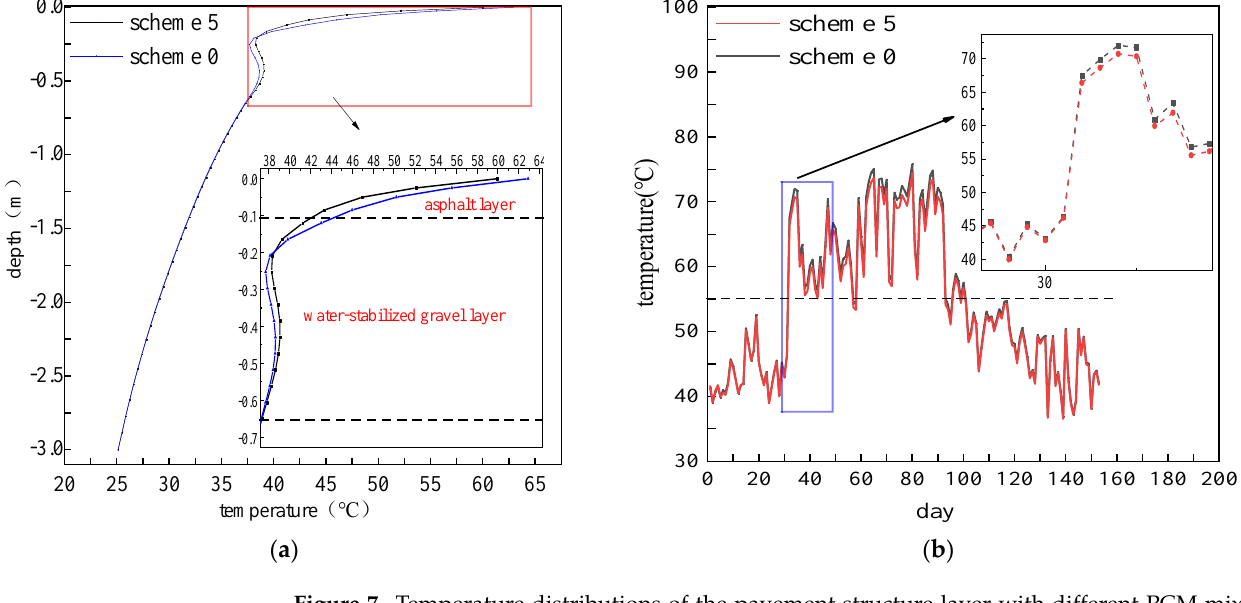
Figure 7. Temperature distributions of the pavement structure layer with different PCM mixing schemes: ( a ) middle hole temperature distributions; ( b ) daily maximum pavement temperature between May 1st to September 30th.